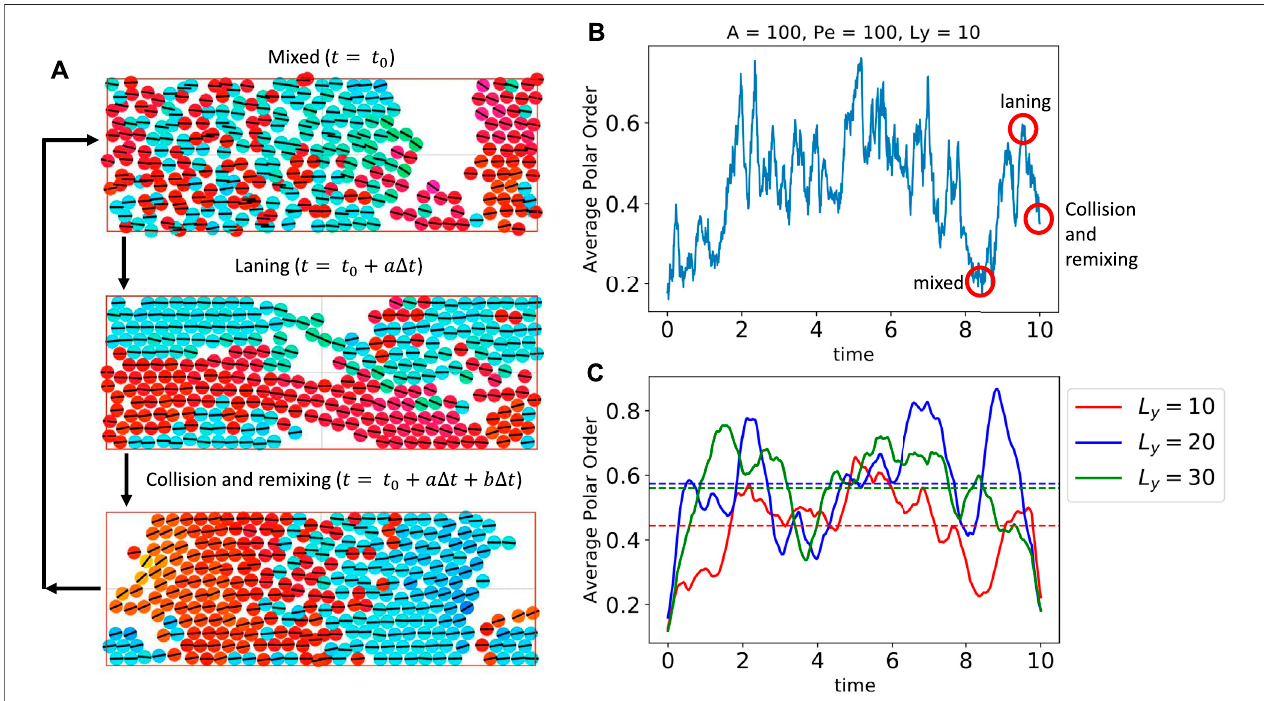
FIGURE9| Travelingchainsinanarrowchannelexhibitcyclesofmixing,laning,andcollisionandremixing. (A) Snapshots ofasimulation where channelwidth has been decreased by a factor of 3. Dynamics of the system are encompassed by three cyclic states: A mixed state shown at an arbitrary initial time t 0 , a phase separated laning state shown a short time after t 0 , and a collision and remixing state shown a short time after the laning state. (B) Polar order averaged over boxes of width 3 σ and height 2.5 σ versustime isshown toelucidate the three states describedin (A) .The polar order for amixed – laning – collision and remixing cycle are shown in the red circles.Whenthesystemiswellmixed, theaveragepolarorderissmall( p ≈ 0.2).Whentheparticles separate intolanes,thepolarorderincreases rapidly( p ≈ 0.6).When thelanesthencollideandbeginremixing,theremnantsofthebulkofthelanesprovidepolarorderwhilemixedparticlesandtheinterfacebetweenlanesdecreasespolar order ( p ≈ 0.4). (C) Polar order averaged over boxes of width 3 σ and height 2.5 σ versus time for three channel widths. Time averaged polar order, shown in dashed horizontal lines, is similar for the L y = 20 and L y = 30 cases when collision dynamics occur in the bulk, but non-interacting traveling chains line the boundaries. Time averaged polar order is smaller for the L y = 10 case as collision dynamics are global phenomena. The full movie corresponding to the narrow channel can be seen in Supplementary Movie S5 .